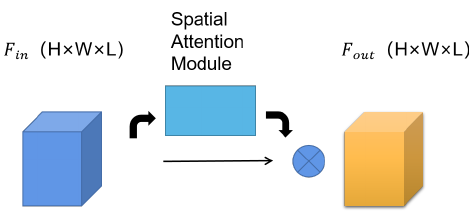
Figure 7. Spatial attention